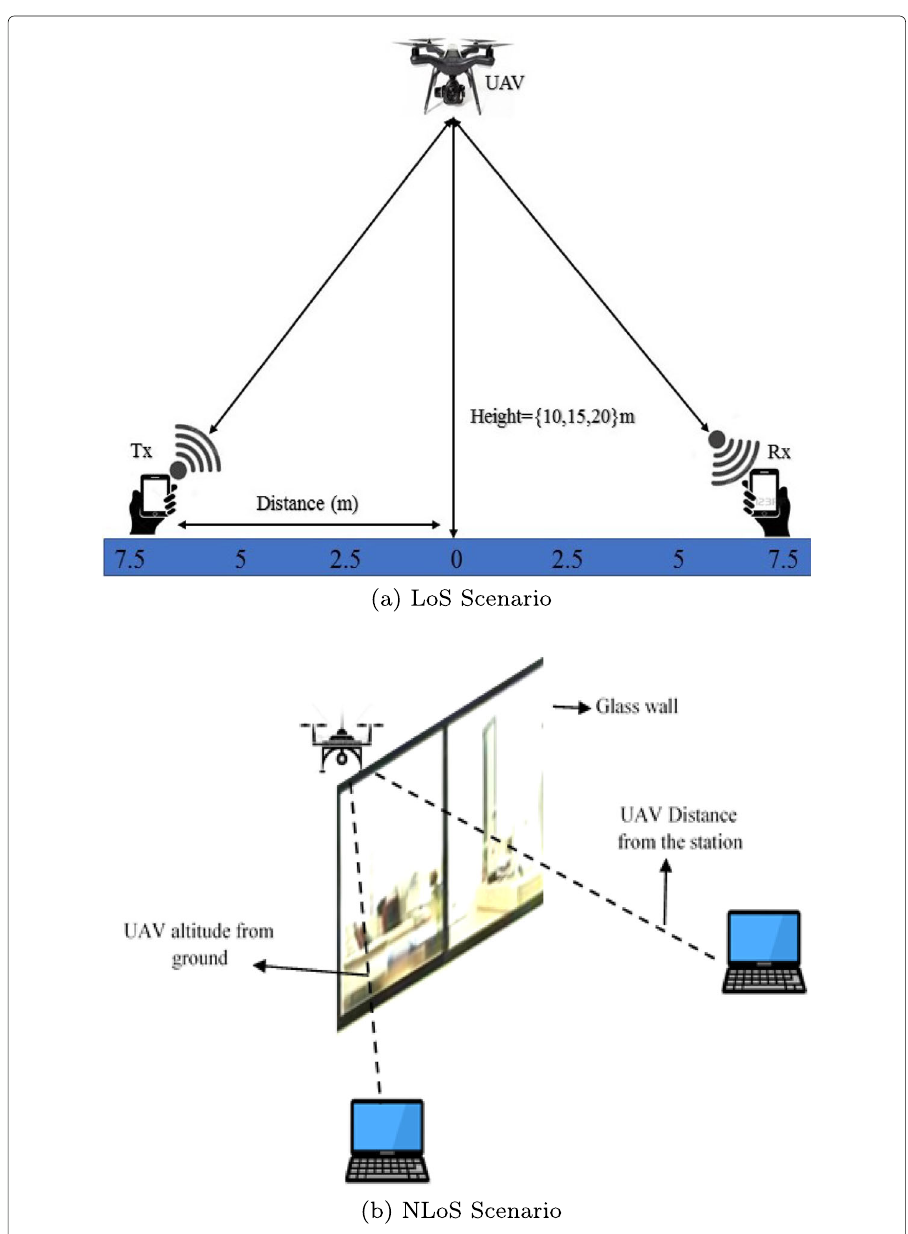
Fig. 1 Experimental setup for both LoS and NLoS scenarios